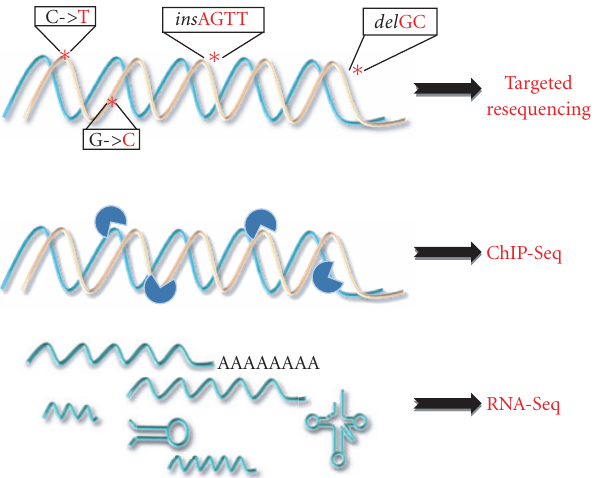
Figure 2: Innovative approaches by using next generation sequencing technologies. Next generation sequencing can be applied to many scientific contexts: targeted resequencing for the identification of disease-causing nucleotide variations for both coding and unexplored regulatory regions of genes (CNV-Seq and DNA-Seq); ChIP-Seq, for DNA-protein interaction studies coupling chromatin immuno- precipitation (ChIP) and massively parallel sequencing; RNA-Seq, for whole transcriptome studies, including expression levels of known and yet unknown transcripts (both coding and non-coding), di ff erential splicing, allele-specific expression, RNA editing, and fusion transcripts (see review